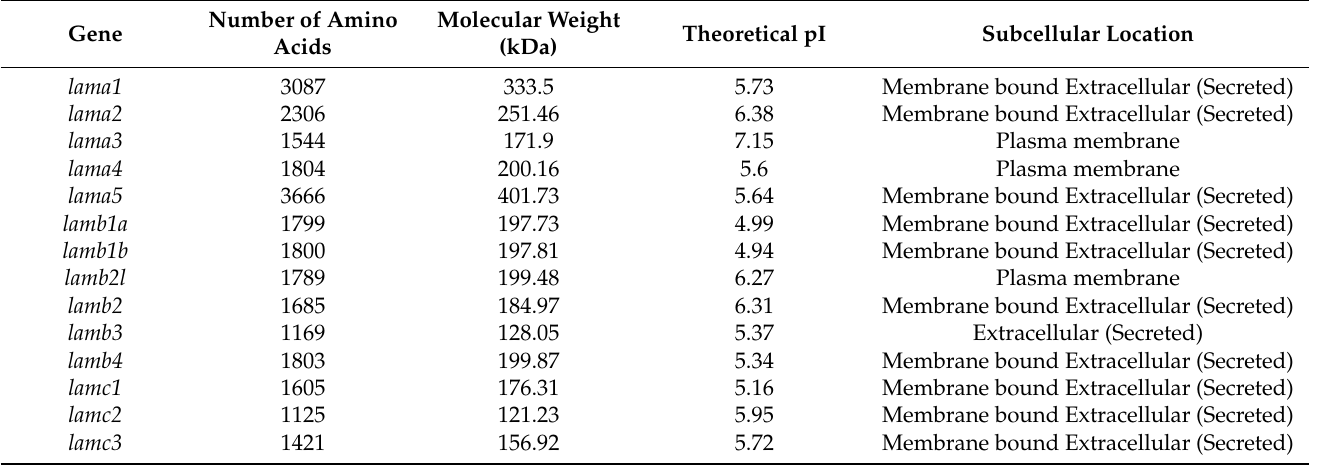
Table 1. Physicochemical properties of